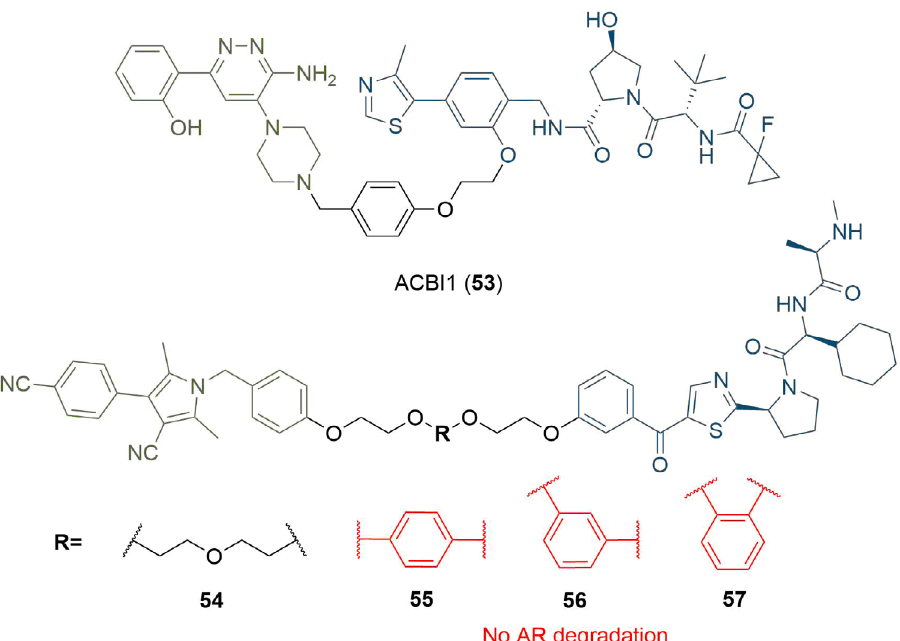
Figure 10. PROTACs with aromatic linkers. The benzyl linker in 53 provided conformational restriction and a pi-stacking interaction with Y98 in VHL. PROTACs 55-57 incorporating a disubstituted phenyl did not display AR degradation, in contrast to parent PROTAC